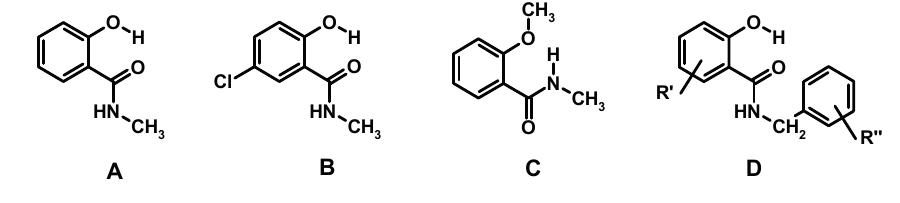
Figure 4. Structures of compounds A , B , C , and D